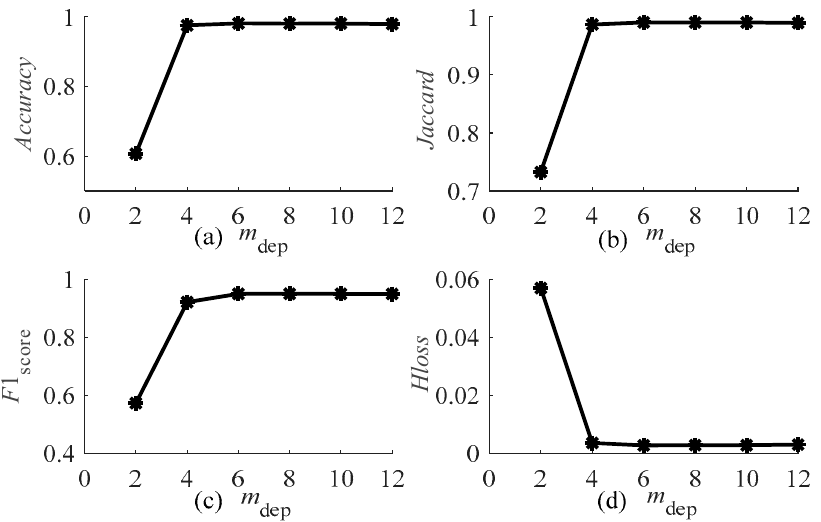
Figure 7. Evaluation results of ML-RF with different maximum depth of tree ( m dep ). ( a ) Accuracy Score; ( b ) Jaccard Similarity; ( c ) F1 Score; ( d ) Hamming Loss.